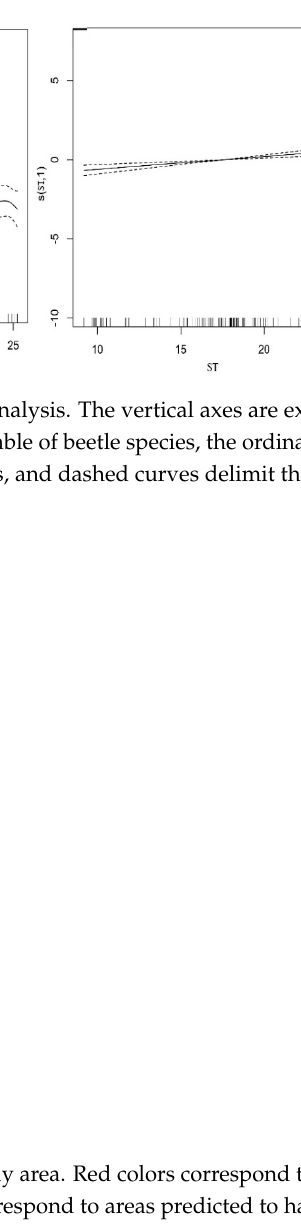
Figure 3. Predictive beetle richness for the study area. Red colors correspond to areas predicted to be species rich, while yellow and green colors correspond to areas predicted to harbor intermedi- ate and low levels of richness.